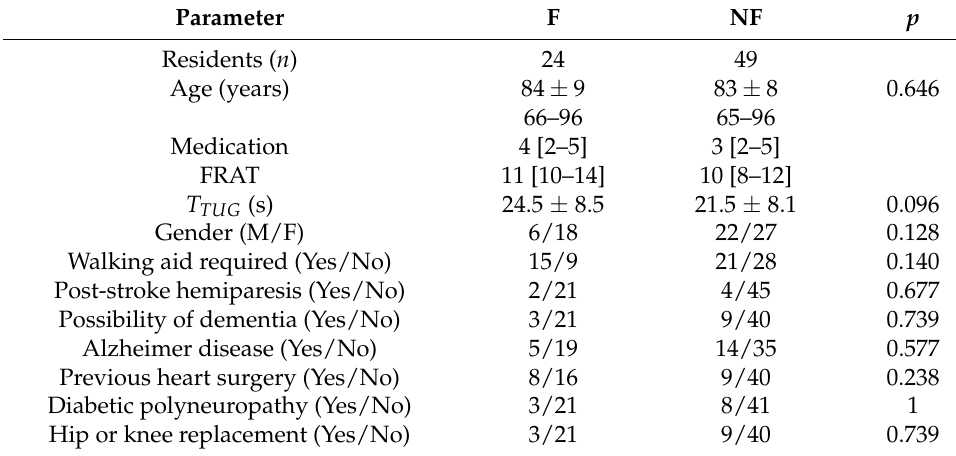
Table 1. General characteristics of the residents. Fallers were identified according to the fall records be- tween the 6-months interval ( t 1 and t 2 ). Numerical data are written under the form mean ± standard deviation ( t -test performed) or median [Q1–Q3] (Mann–Whitney test performed). For the age, the minimum and maximum values in each group are given (second line). Exact Fisher tests were performed for the categorical data (M/F or Yes/No). p -values for the comparison between fallers (F) and non-fallers (NF) groups are given in the last column. Total TUG time ( T TUG ) was assessed with a stopwatch. Medications included: psychotrope, antiarrhythmic, and diuretics. Hypertension is defined as a value > 140/90